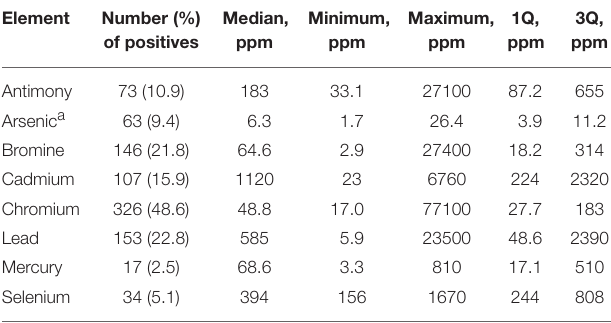
TABLE 3 | Frequency of detection and summary statistics for the hazardous elements in beached Lake Geneva plastics.